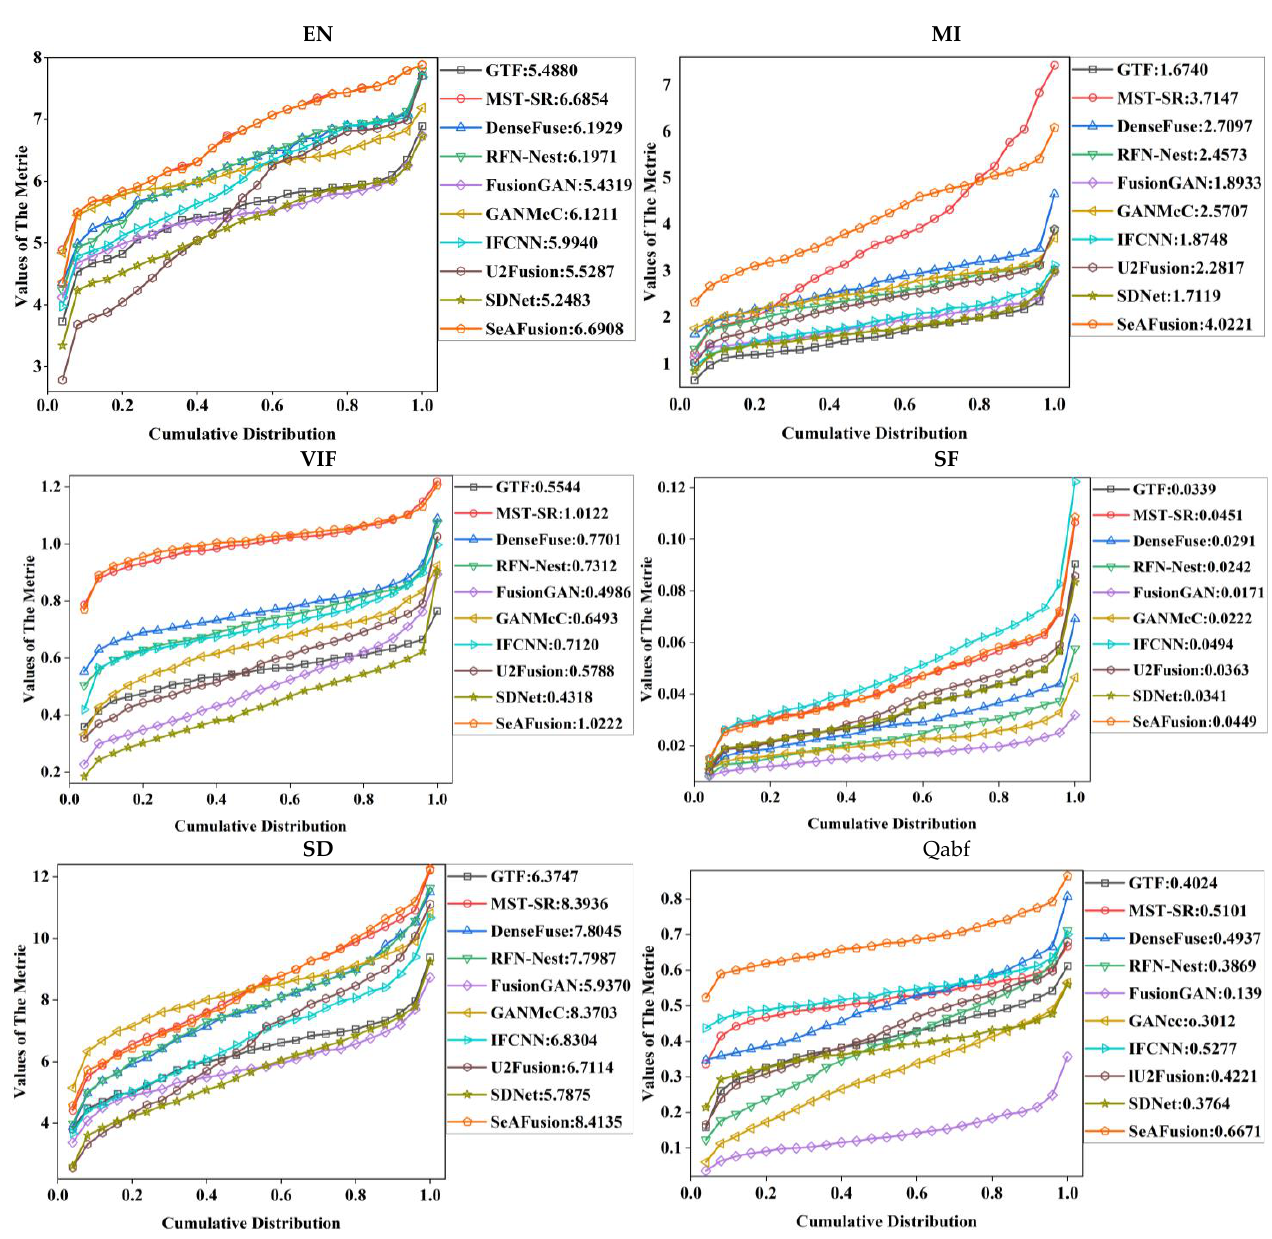
Figure 12. Quantitative comparison of EN, MI, VIF, SF, SD, and Qabf indicators for 361 image pairs from the MFNet dataset.